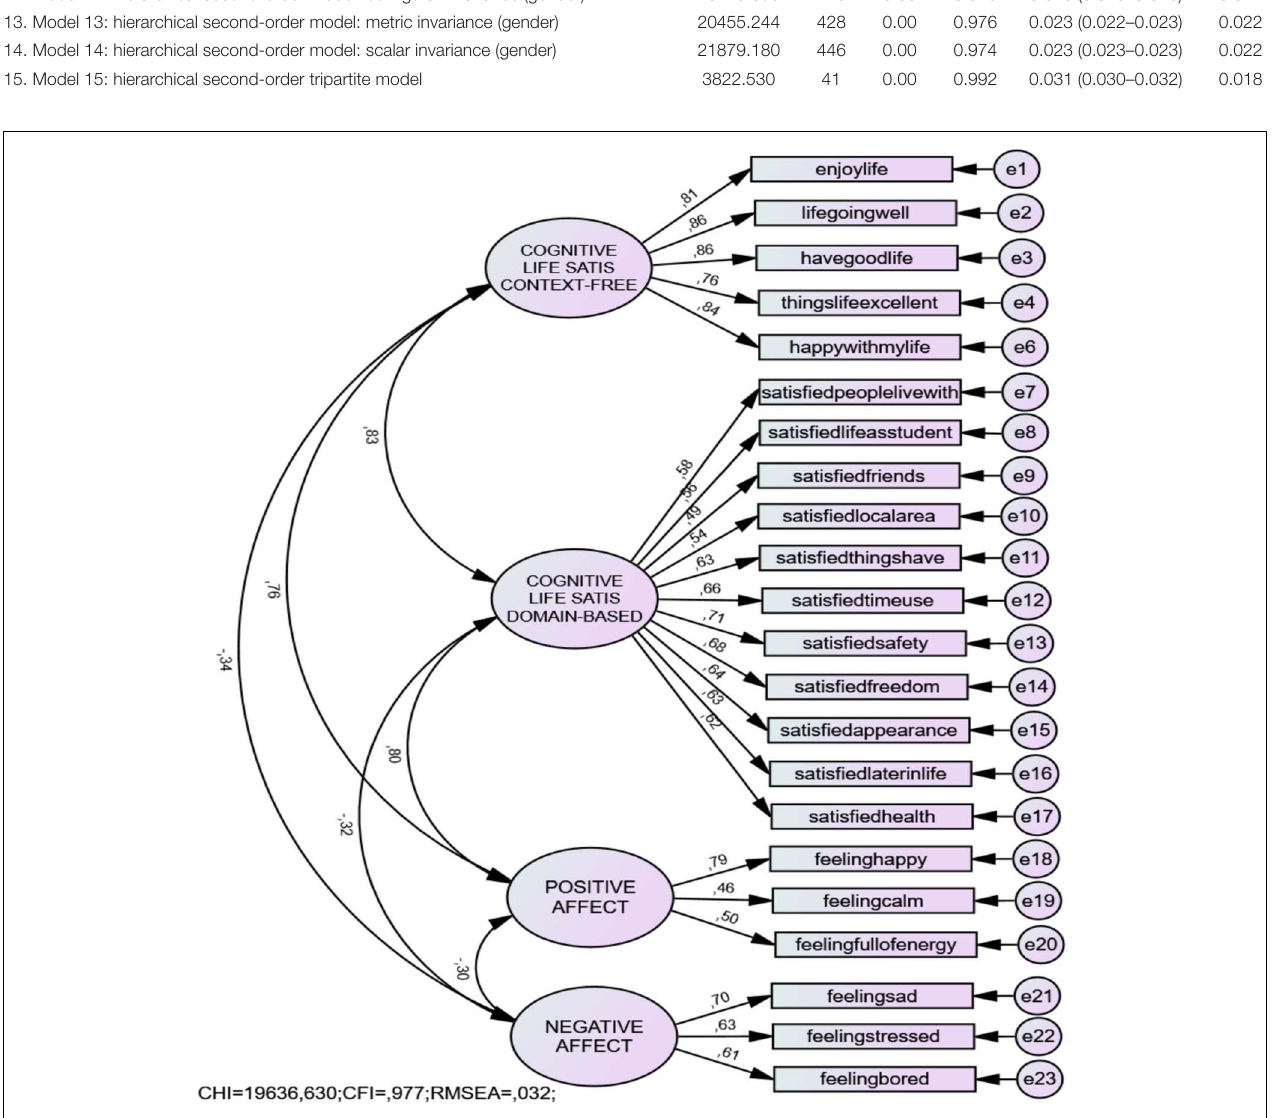
FIGURE 1 | Four-factor confirmatory factor